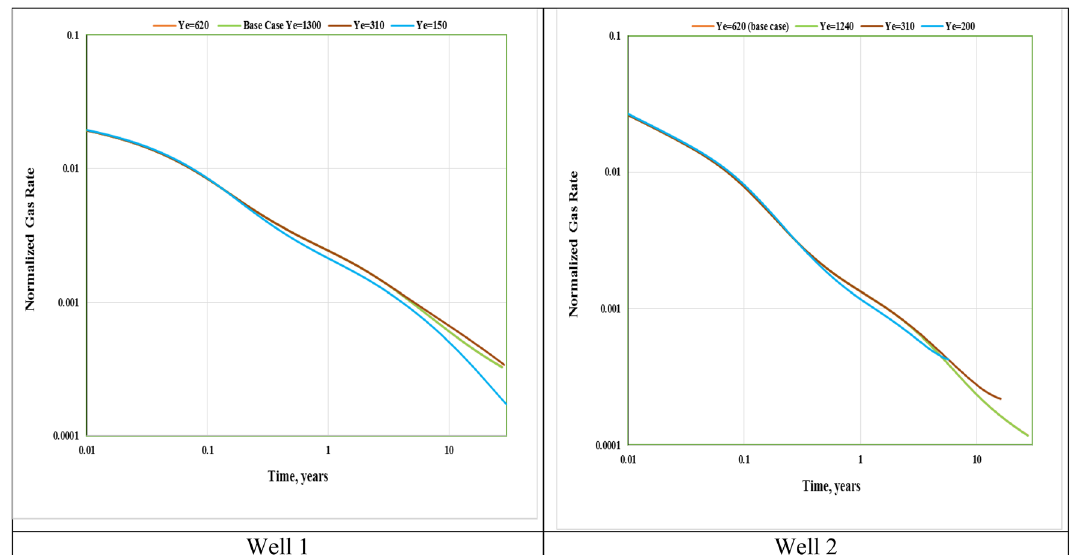
Fig. 12 Well spacing sensitivity